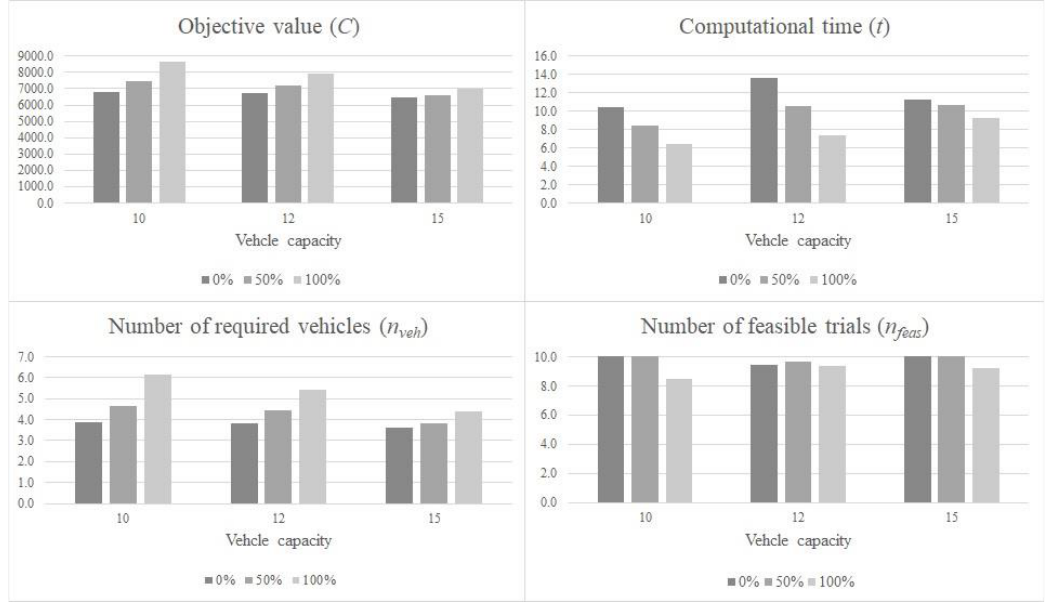
Figure 8. Results for instances with Pr = { 0%, 50%, 100% }